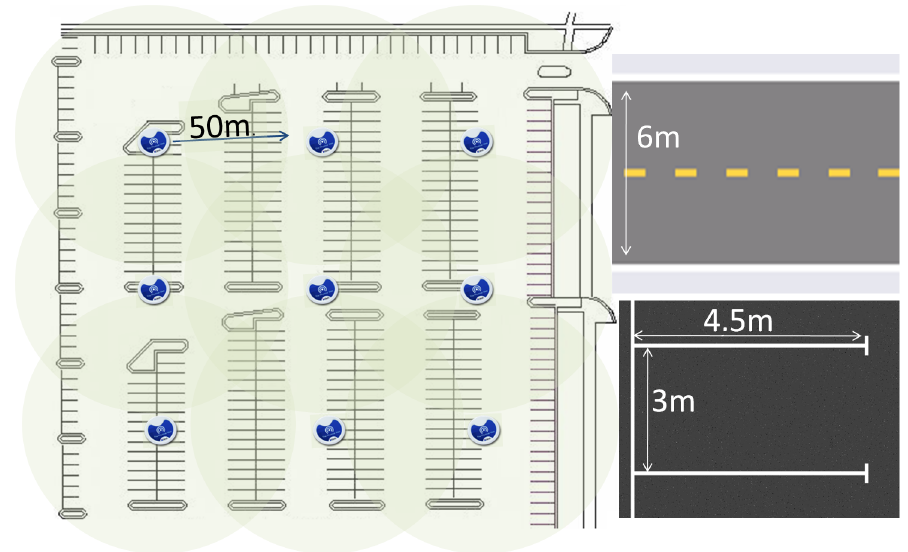
Figure 5. Example of parking facility with nine Bluetooth Low Energy (BLE)